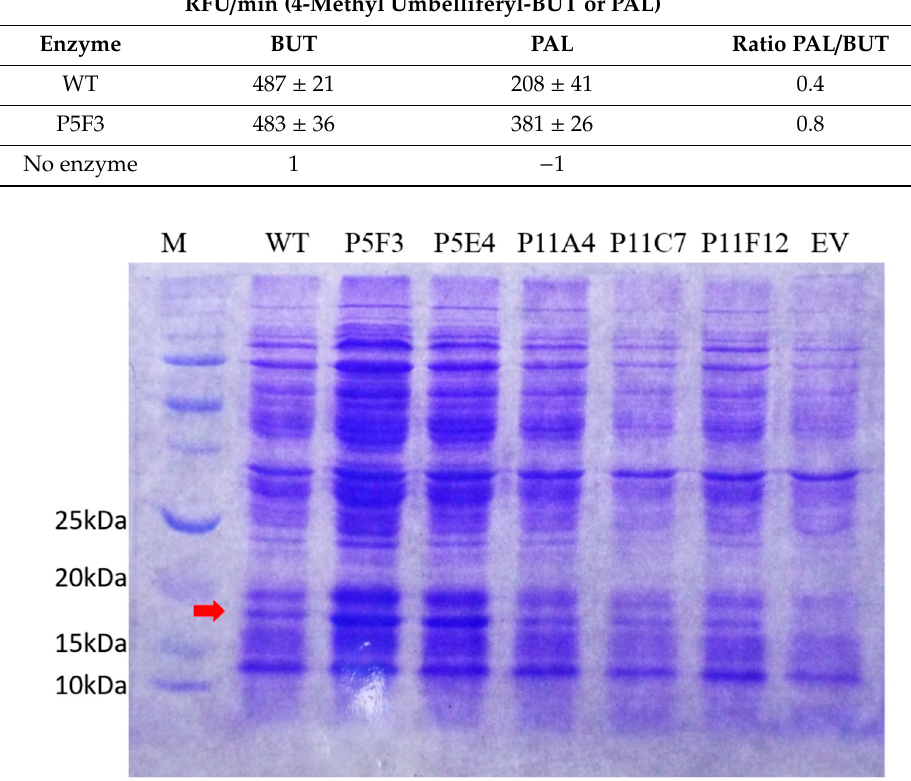
Table A3. Activity comparison for wildtype BSLA and P5F3variant using the fluorogenic substrate 4-methyl umbelliferyl-fatty acid ester (BUT or PAL) instead of the chromogenic p -nitrophenyl fatty acid ester substrates.